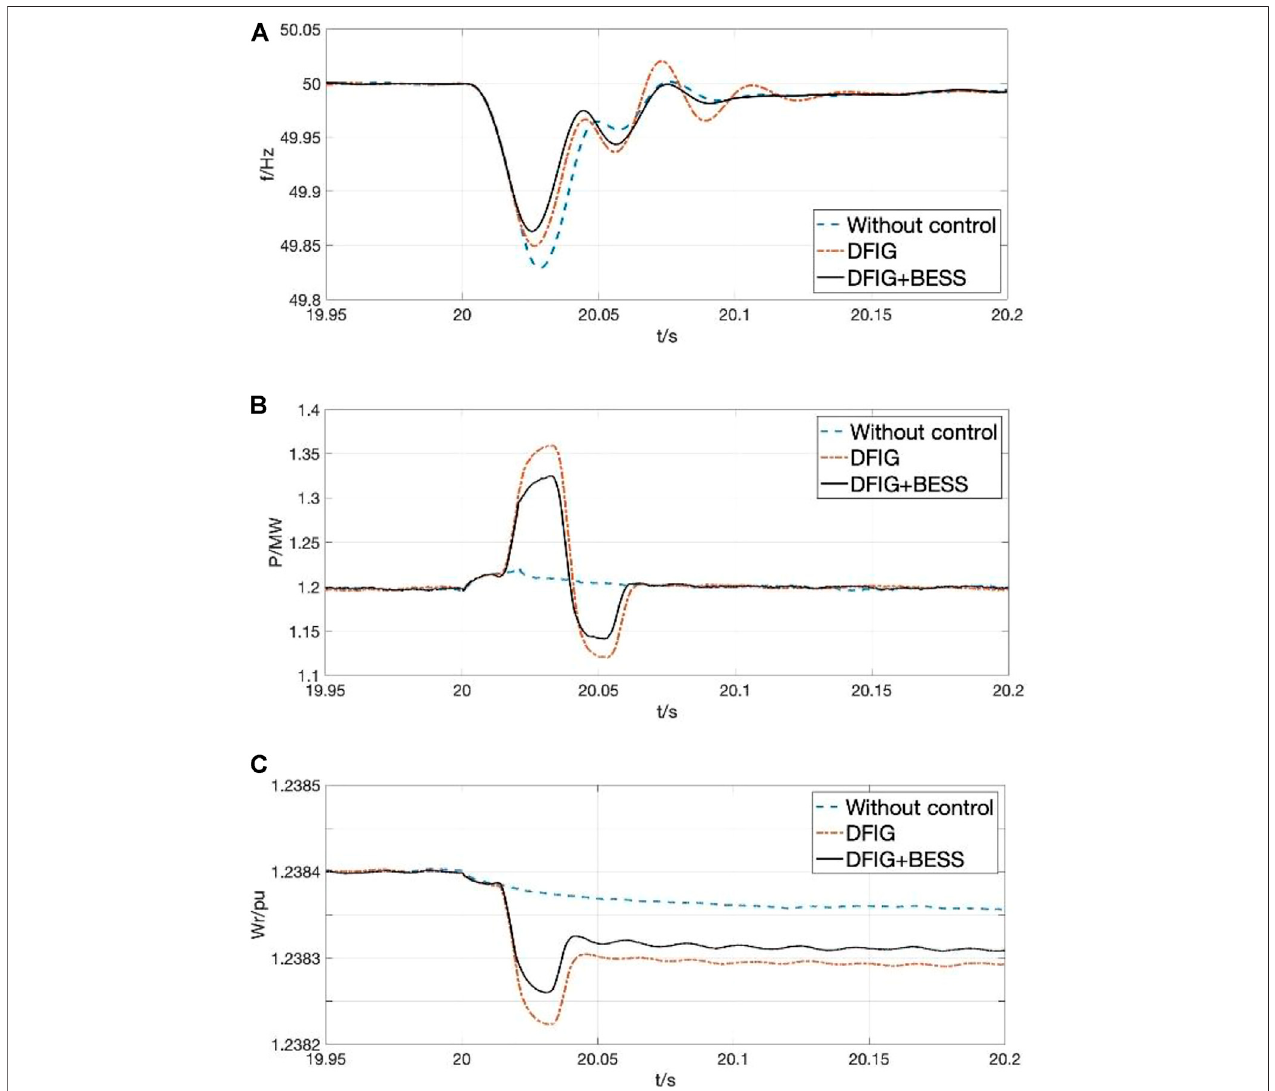
FIGURE 9 | Results for case 3. (A) system frequency. (B) turbine power output. (C) rotor speed.